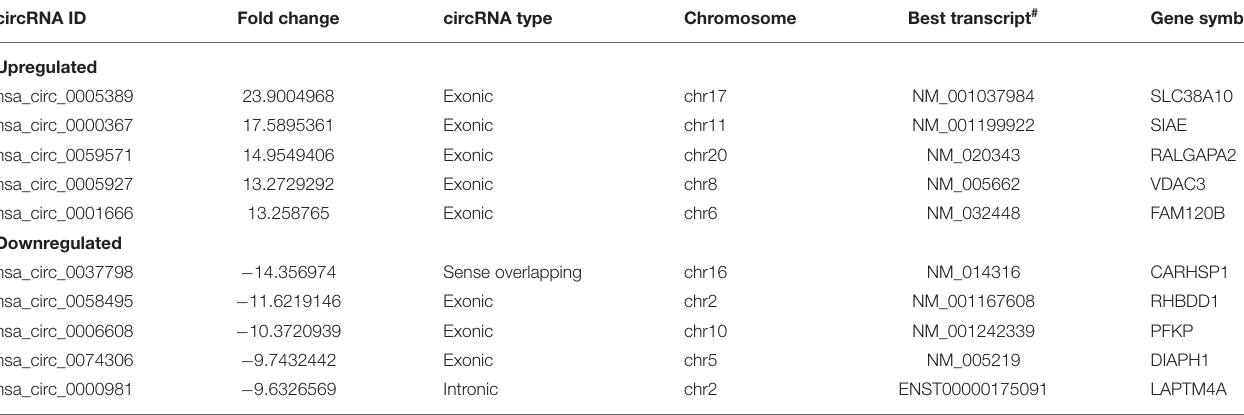
TABLE 3 | Biological information of the selected five circRNAs. circRNA ID Fold change circRNA type Chromosome Best transcript # Gene